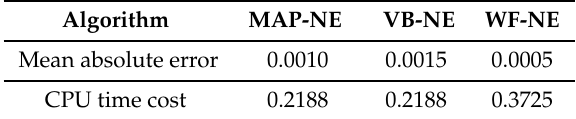
Table 1. The mean absolute error of three noise estimation algorithms in Situation 1.